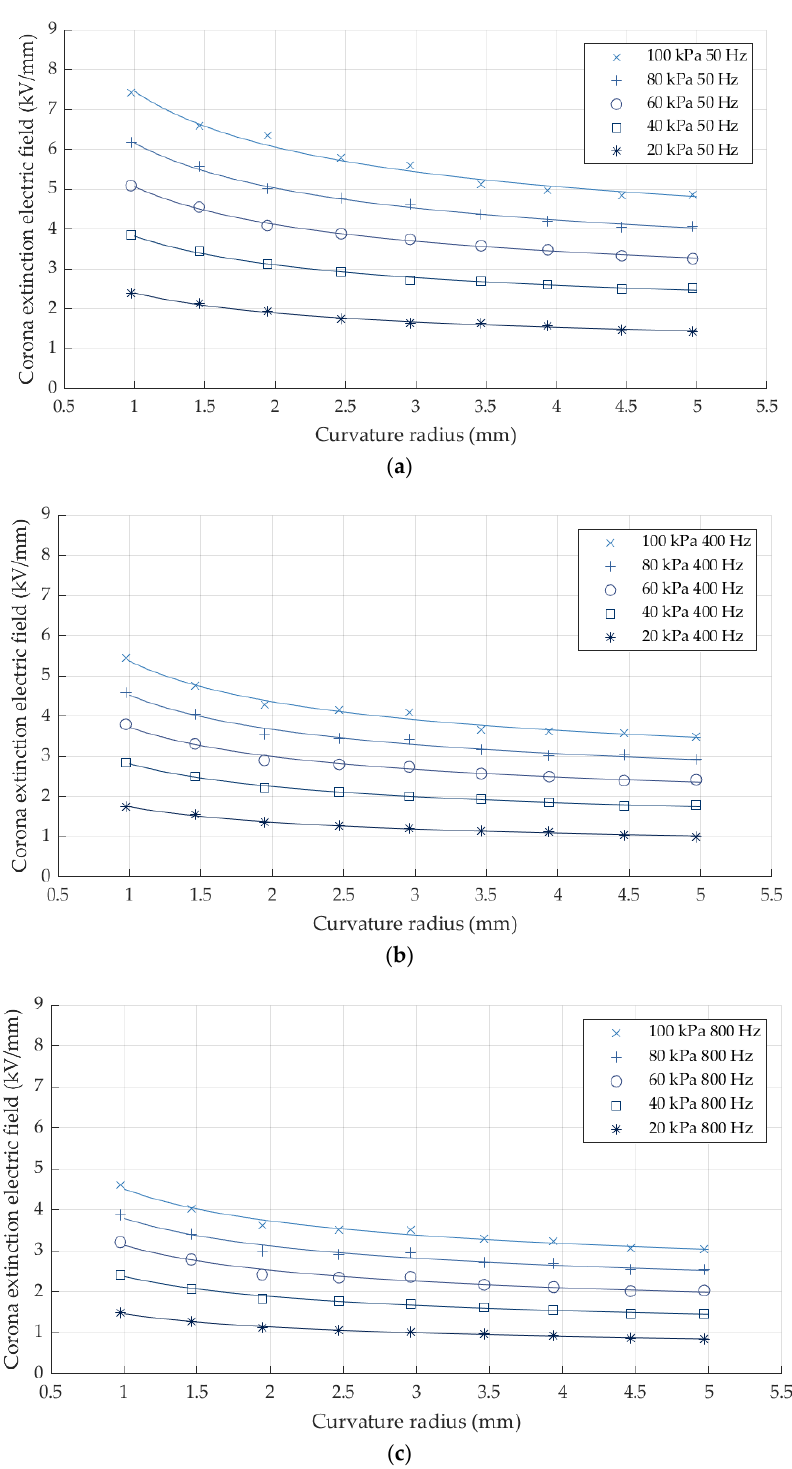
Figure 6. Corona extinction electric field strength versus the curvature radius of the sphere. ( a ) Peak’s curve regression for 50 Hz. ( b ) Peak’s curve regression for 400 Hz. ( c ) Peak’s curve regression for 800 Hz.